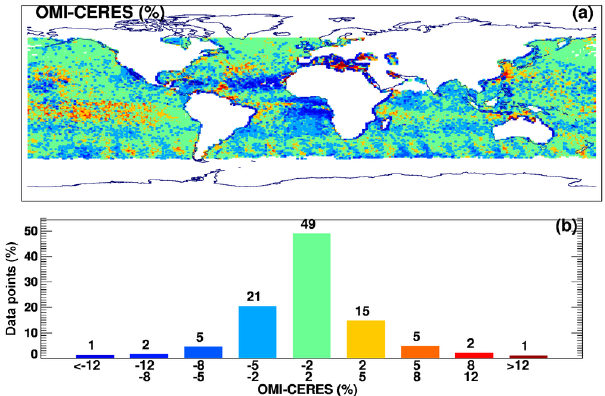
Figure 11. Similar to Fig. 10c and d but with a NN trained using data from the OMI cloud O 2 –O 2 product for July